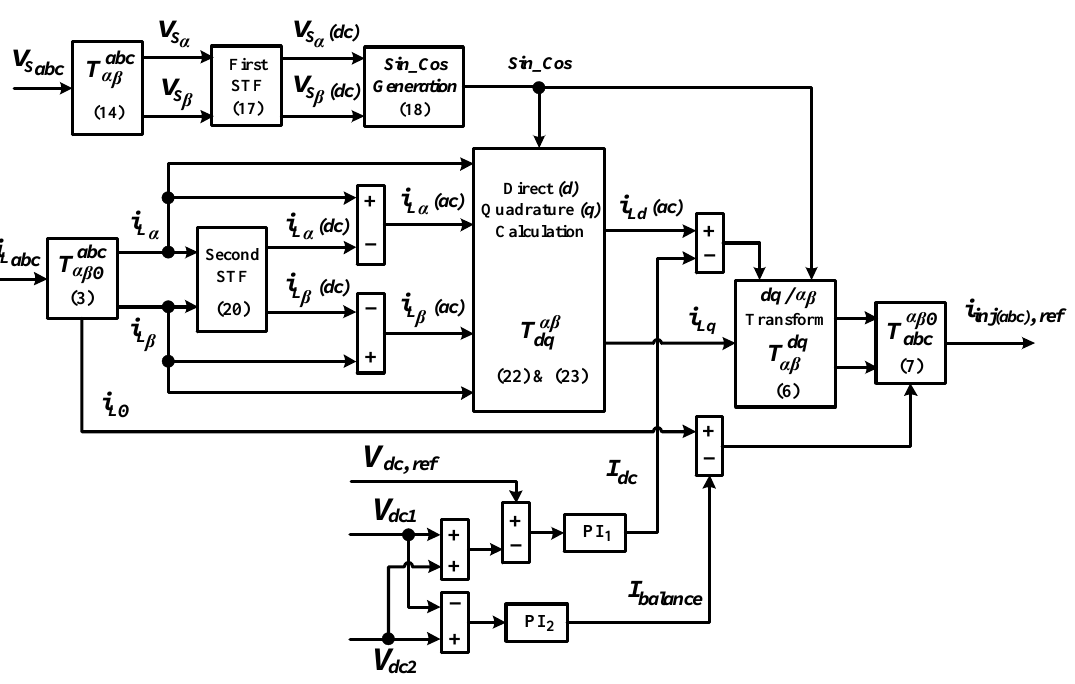
Figure 3. Block diagram showing control structure of the proposed self-tuning-filter (STF)- dq 0 technique.